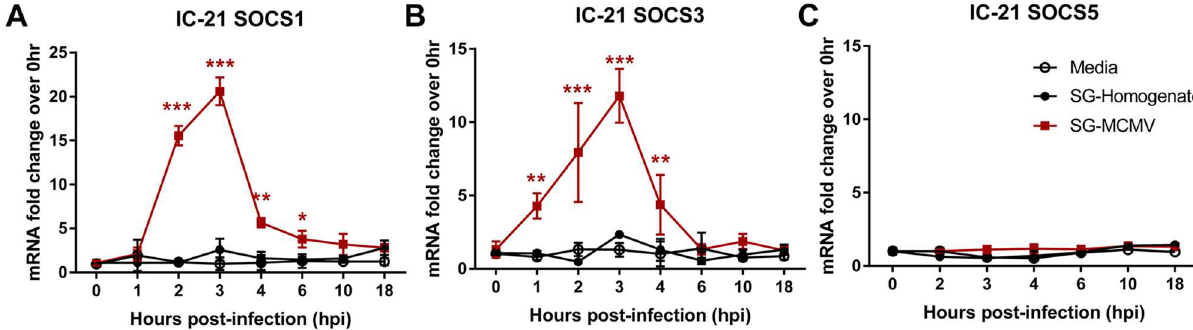
Fig 1. Infection of mouse macrophages with MCMV stimulates SOCS1 and SOCS3, but not SOCS5, mRNA transcripts at early time points. IC-21 mouse macrophages were treated with media (control) or infected with SG-MCMV (MOI = 3 PFU/cell) or SG-homogenate. At indicatedtime points, cells were harvested and assessed for SOCS1 mRNA (A) , SOCS3 mRNA (B) , or SOCS5 mRNA (C) by real-time RT-PCR assay using the comparative 2 - ΔΔ Ct method, with all samples comparedback to the media group at 0 hpi. Means ± SD of triplicate experimental repeats are shown. * p < 0.05, ** p < 0.01,and *** p < 0.001,comparedwith respectivemedia controls at the same time